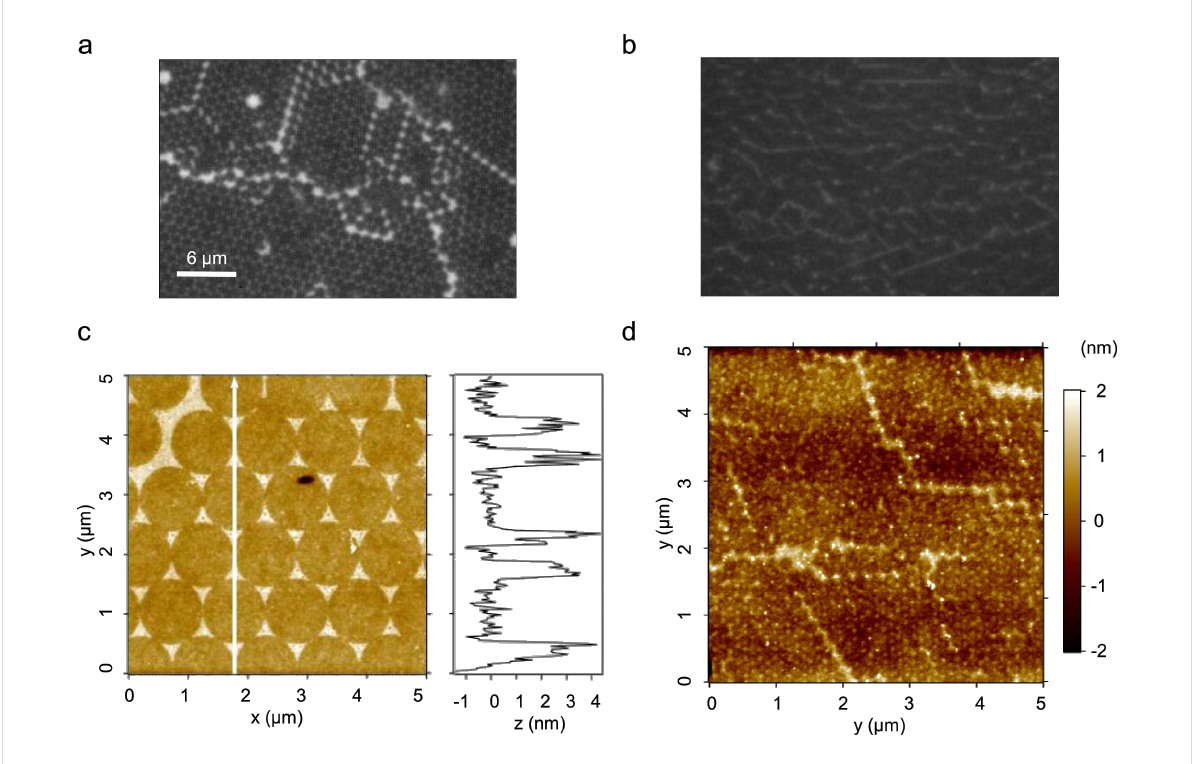
Figure 4: Hybrid UV-light and ozone near-field chemical nanostructuring of an ATPES-SAM (process 3). Fluorescence micrographs of nanopatterns based on masks obtained from projection pattern of (a) 1.2 µm latex beads and of (b) 220 nm latex beads after staining of the chemically functional- ized areas with fluorescein molecules. Optically only the larger hexagonal nanopattern can be resolved, whereas the fluorescence image of the 220 nm pattern is characterized by defect structures. (c) AFM micrograph of 1.4 nm negatively charged nanoparticles site-selectively bound to trian- gular shaped APTES-functionalized nanostructures reproduced the detailed lateral structure of the applied mask. (d) Topography image of the same fluorescein stained sample as shown in